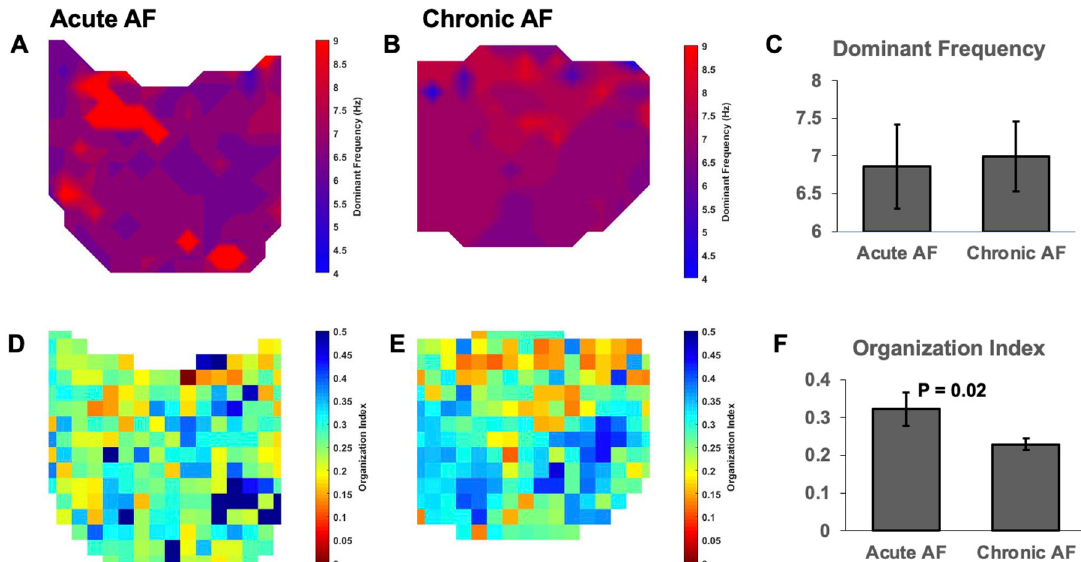
Fig 5. Right atrial changes in dominant frequency and organizational index. (A-B) Representative right atrial DF maps for paroxysmal and persistent AF. There was no significant difference with the right atrial DF between paroxysmal andpersistent AF (6.9 vs. 7.0, P = 0.72). (C,D) Representative right atrial OI maps of paroxysmal and persistent AF. Right atiral OI significantly decreased during persistent AF (0.23 vs. 0.32, P =